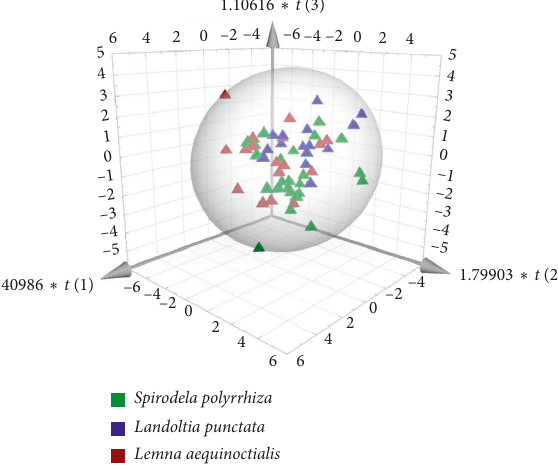
Figure 5: Three-dimensional score plot of orthogonal partial least squares-discriminant analysis (OPLS-DA) based on the ratio of free to total amino acids.